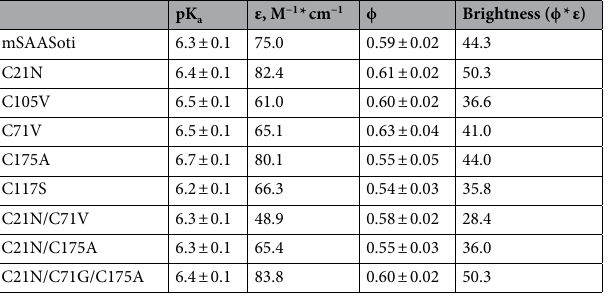
Table 2. Physicochemical properties and fluorescent parameters of different mSAASoti mutant forms.